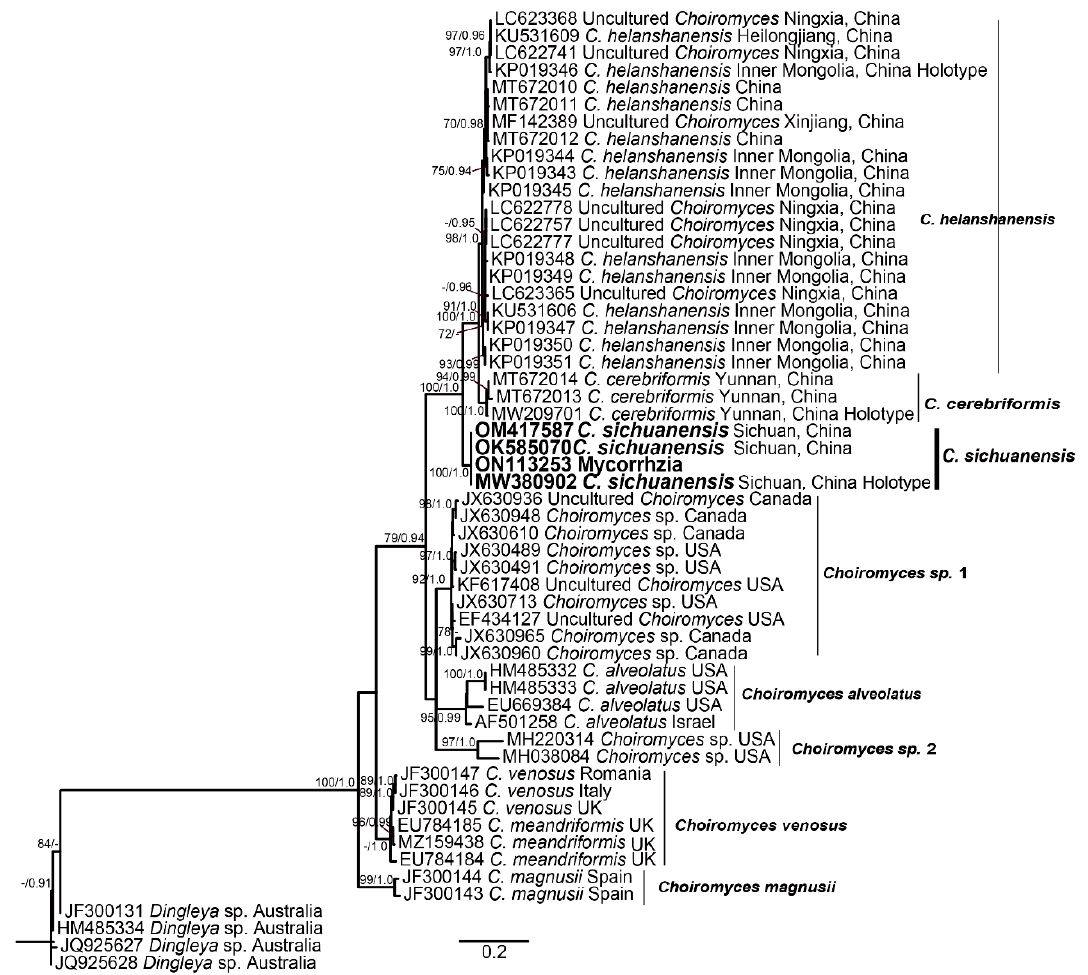
Figure 3. RAxML tree based on ITS sequences of Choiromyces sichuanensis and related species. Boot- strap (BS) values derived from maximum likelihood (ML) analysis ( ≥ 70%) and posterior probabilities (PPs) from Bayesian inference ( ≥ 0.90) are shown above or beneath the branches at nodes. New sequences are in colored bold font.